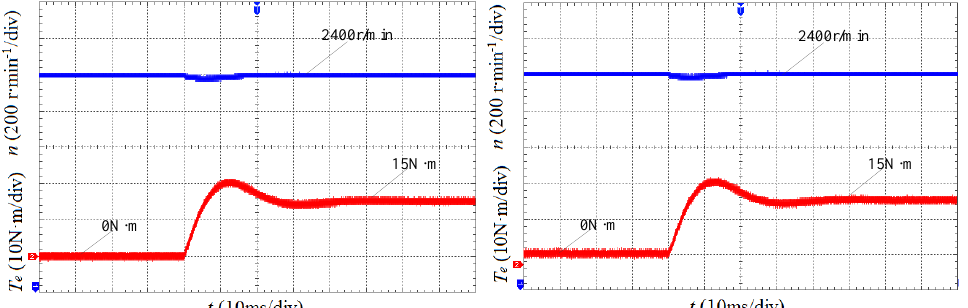
Figure 28. Experimental electromagnetic torque T e and rotor speed n ( left ) DZIPWM; ( right ) DZICMV.